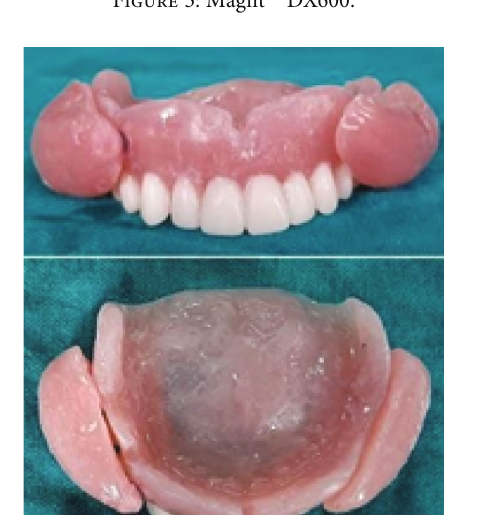
Figure 5: Mag fi t ™ DX600.